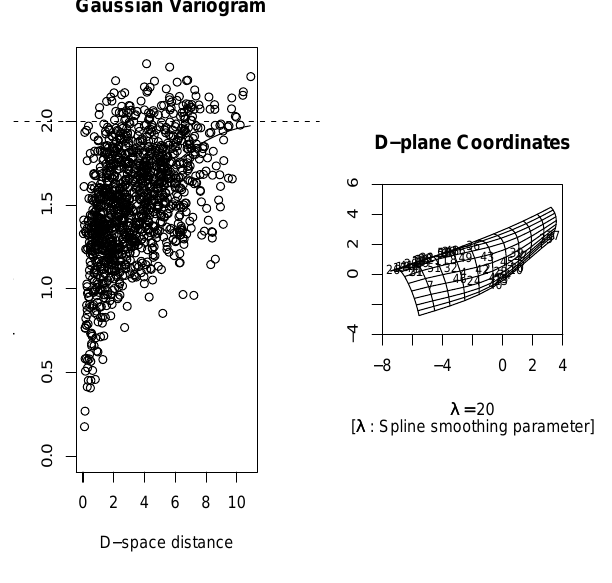
Hussain et al.: Hierarchical Bayesian space-time Interpolation versus Spatio-Temporal BME Approach